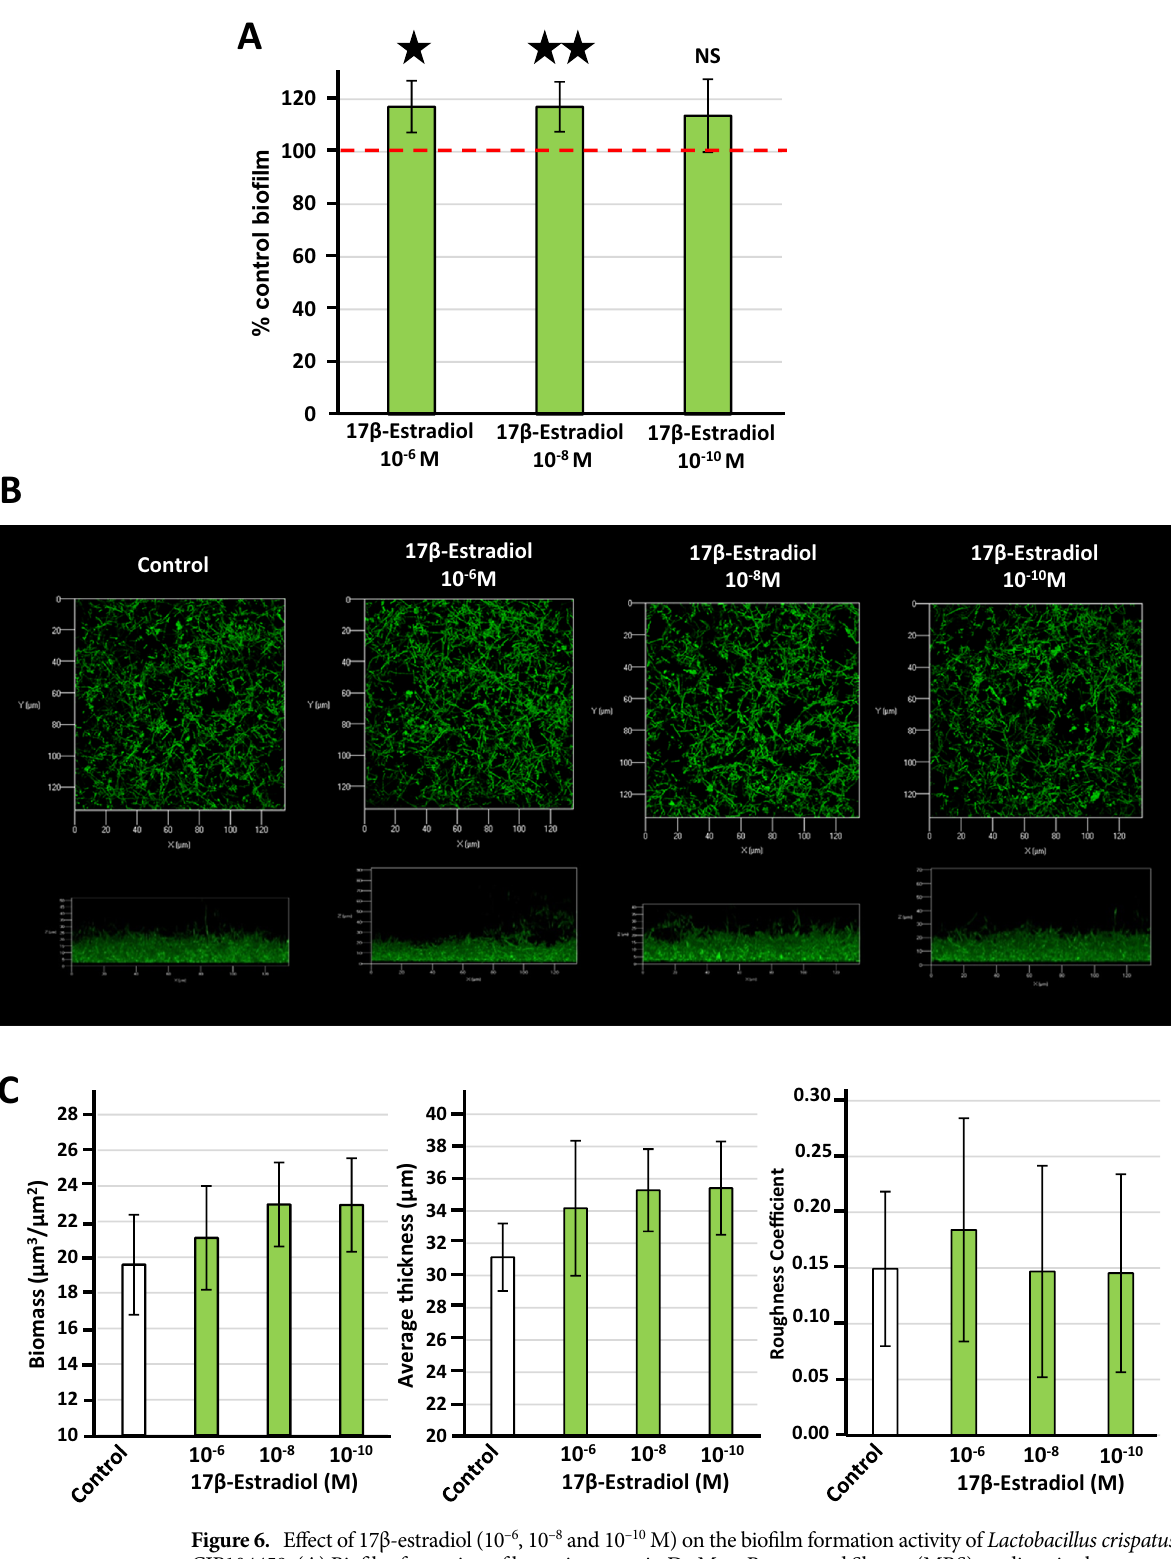
Figure 6. Effect of 17β-estradiol (10 –6 , 10 –8 and 10 –10 M) on the biofilm formation activity of Lactobacillus crispatus CIP104459. ( A ) Biofilm formation of bacteria grown in De Man, Rogosa and Sharpe (MRS) medium in the presence or absence of 17β-estradiol studied by the crystal violet technique. The dotted line indicates the control level